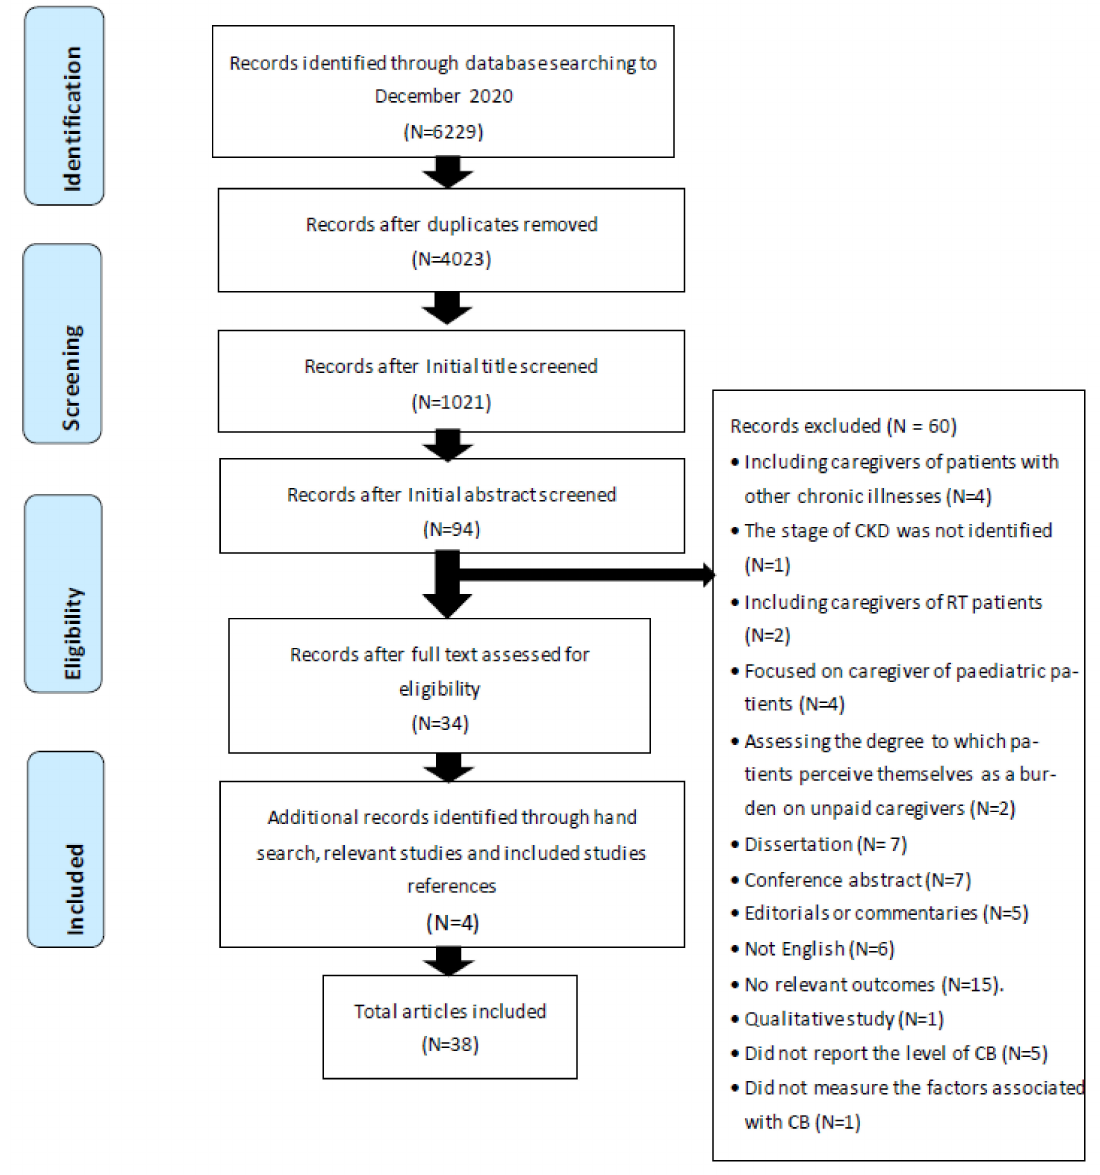
Figure 1. PRISMA flowchart